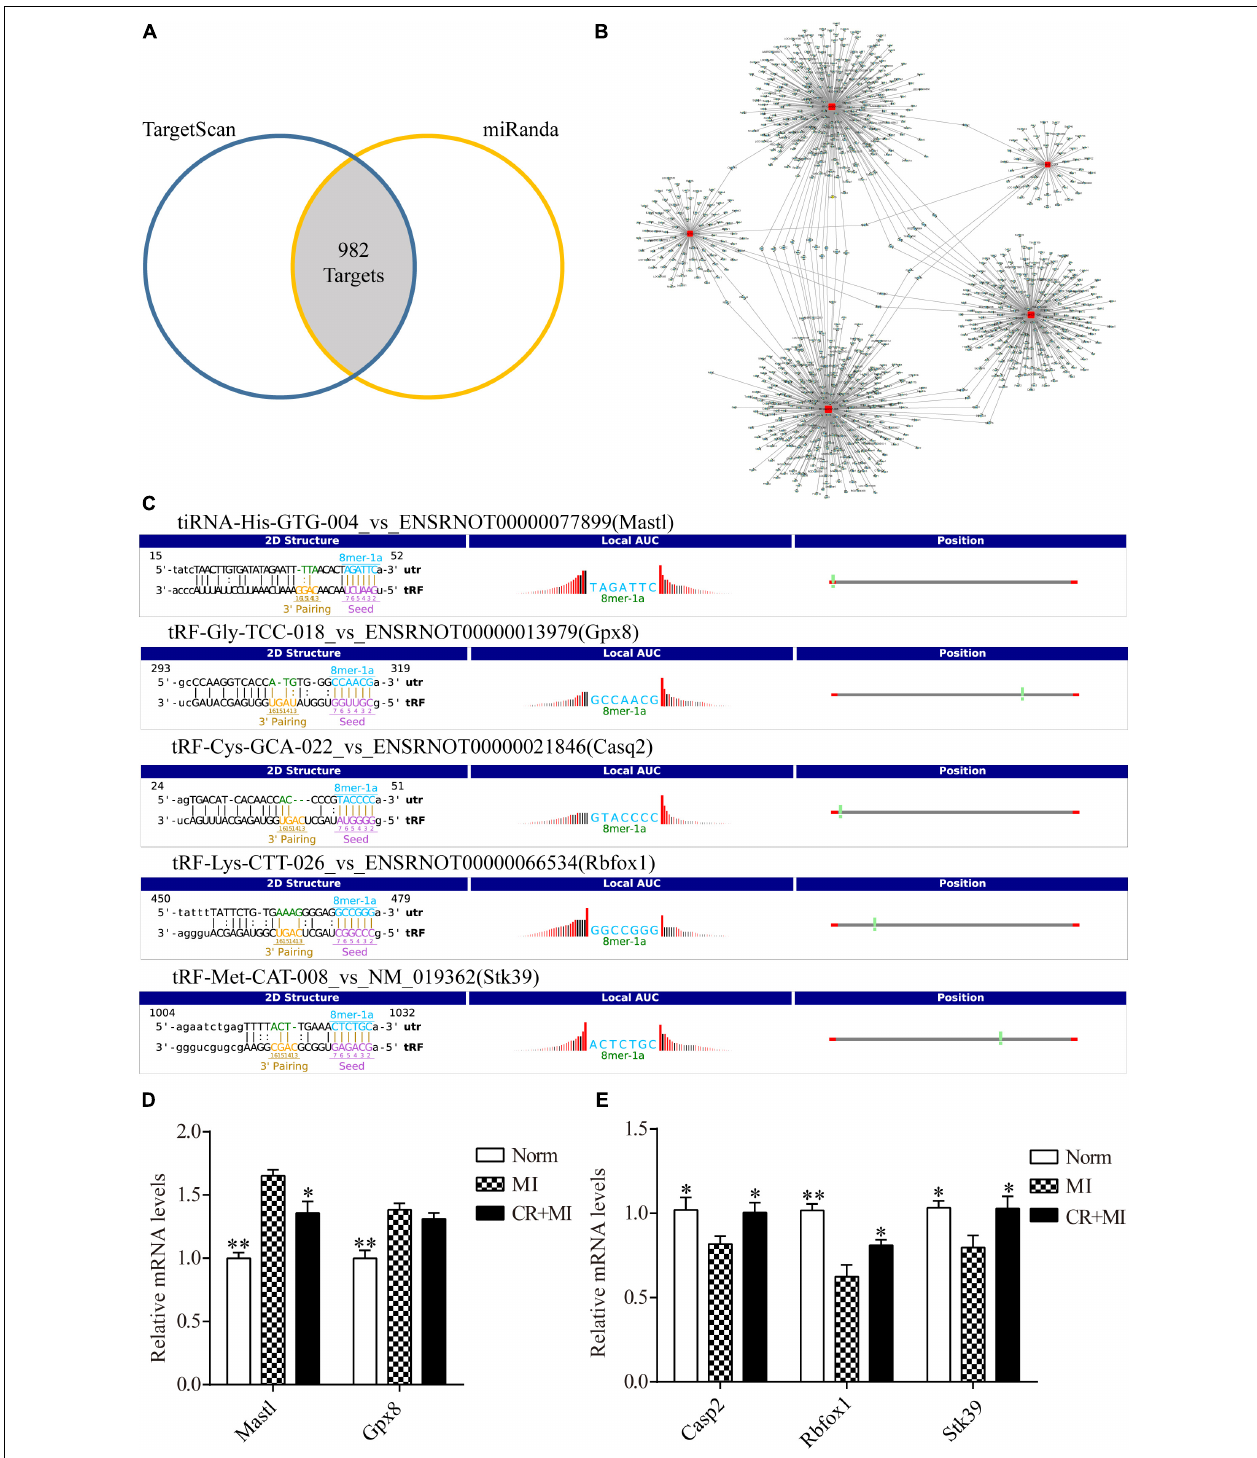
FIGURE 5 | Target genes of CR-related tsRNAs and their verification. (A) Venn diagram showing 982 mRNA targets of five CR pretreatment–related tsRNAs that were predicted by two prediction algorithms. (B) The target of each tsRNA is shown separately. (C) The binding region and seed sequence of five randomly selected mRNA transcripts (each corresponding to a tsRNA sequence). (D) Verification of target predictions of Mastl and Gpx8 via qRT-PCR. (E) Verification of target predictions of Casp2, Rbfox1, and Stk39 via qRT-PCR. The data are presented as the mean ± SEM ( n = 6). * P < 0.05, ** P < 0.01 compared with the MI group.